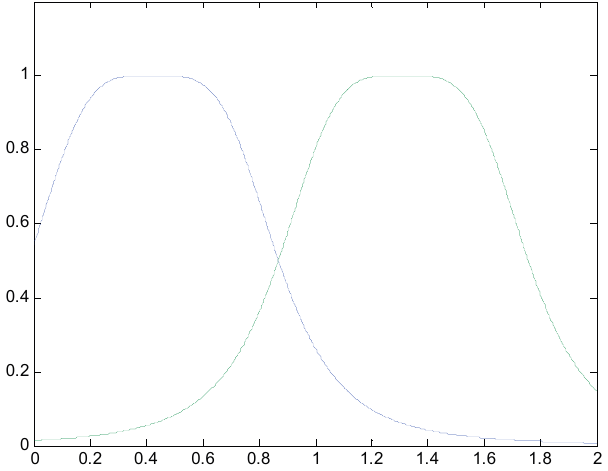
Figure 3. Initial membership function diagram of four input variables.